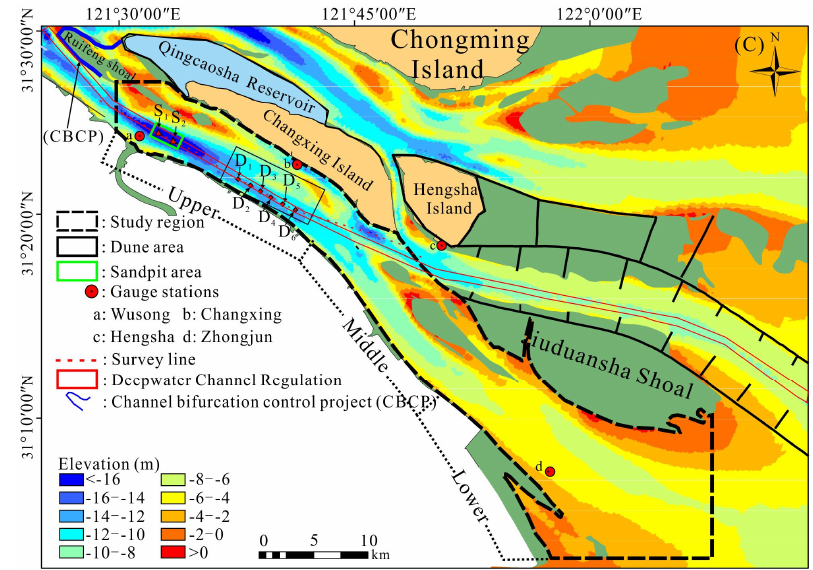
Figure 1. ( A ) Geographical location of the Yangtze River Basin in China. ( B ) the Yangtze River Estuary. ( C ) The study area: The South Channel and South Passage (SCSP).